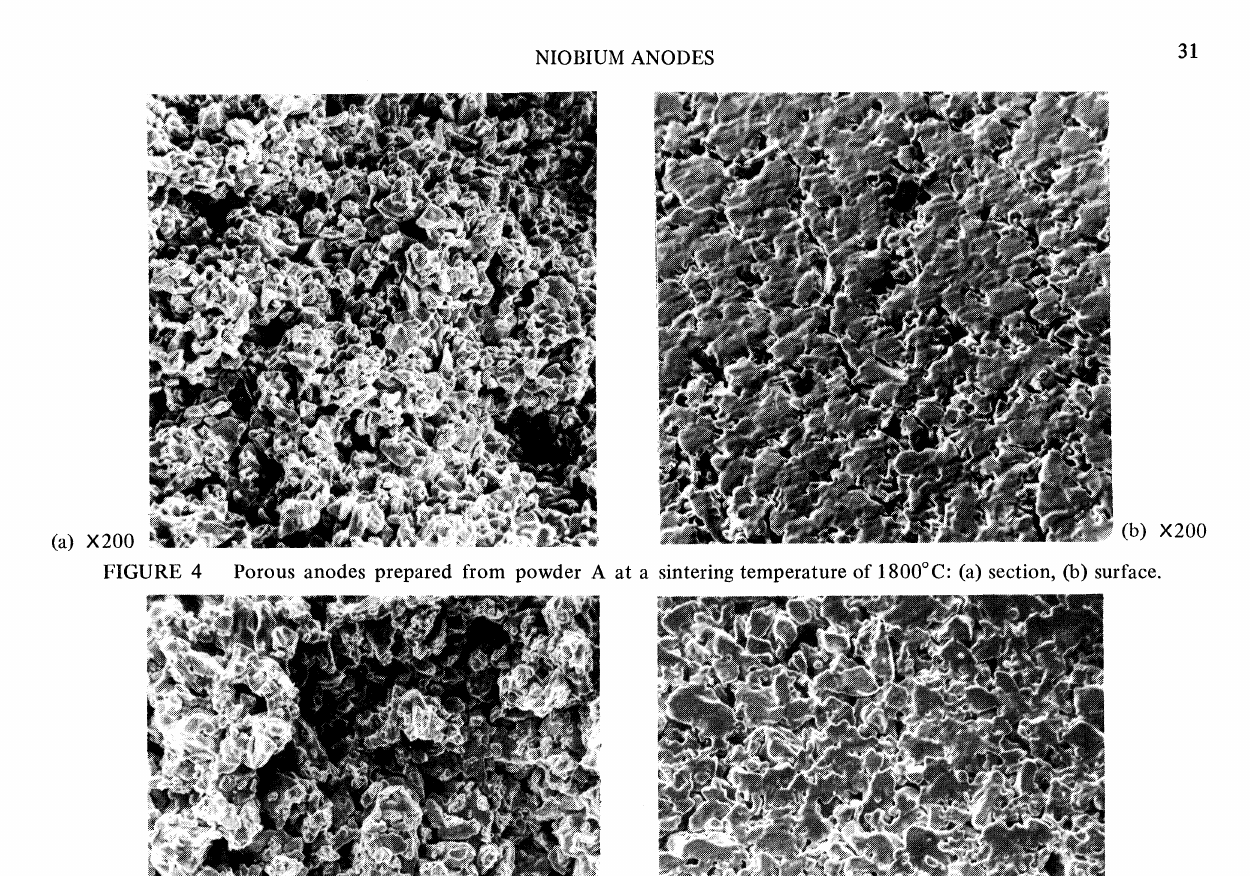
Porous anodes prepared from powder A at a sintering temperature of 1800 C: (a) section, (b) surface.